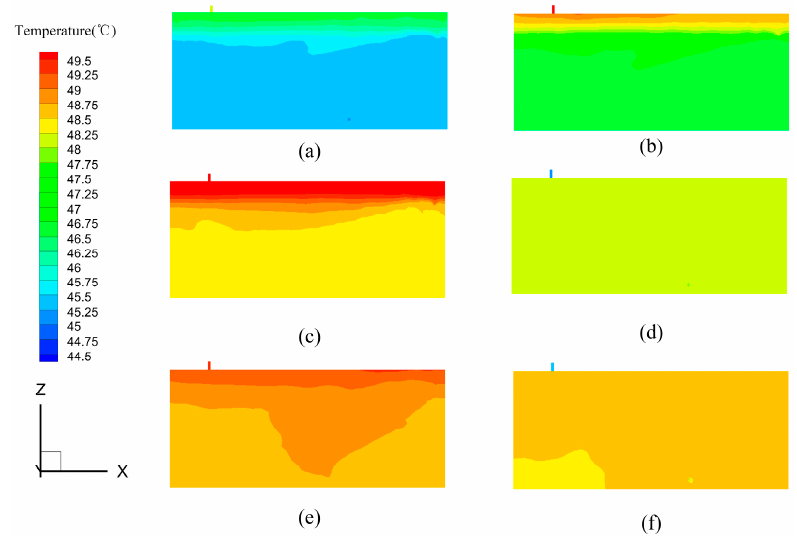
Figure 9. Temperature distribution of the heat storage tank (Y = 0): ( a ) 12:00; ( b ) 13:00; ( c ) 14:00;